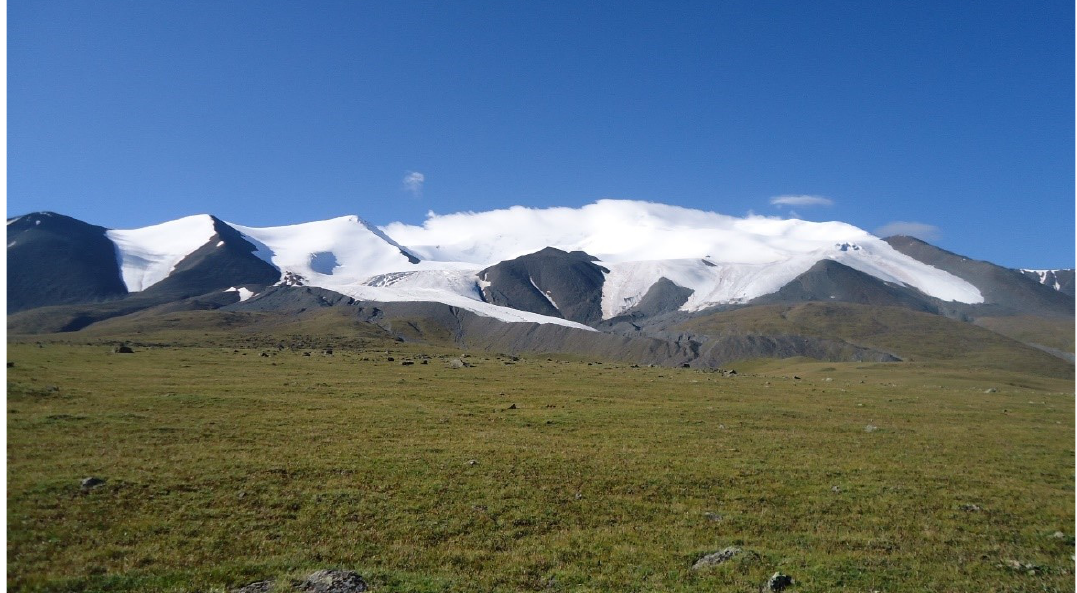
Fig. 2. A view of the modern glacier on southwestern slope of Mt. Tsambagarav. Photo by A. Orkhonselenge on